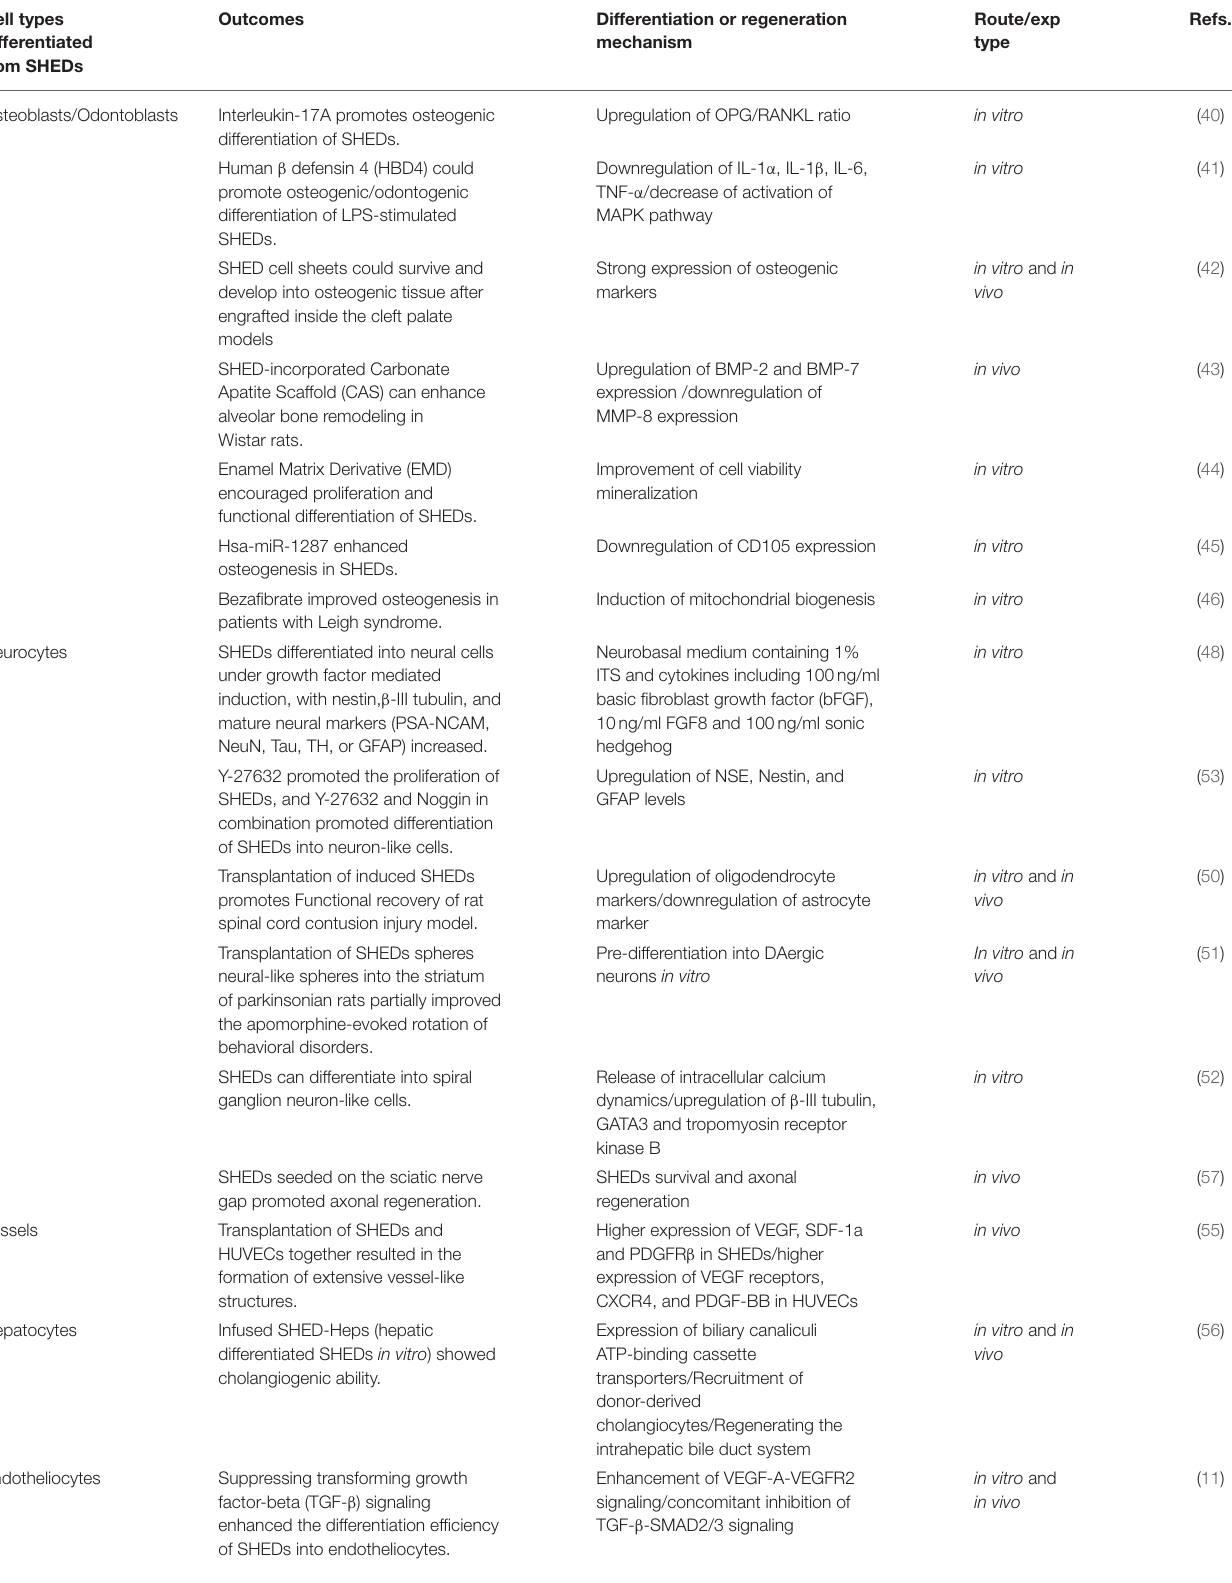
TABLE 1 | Multi-lineage differentiation of SHEDs. Cell types